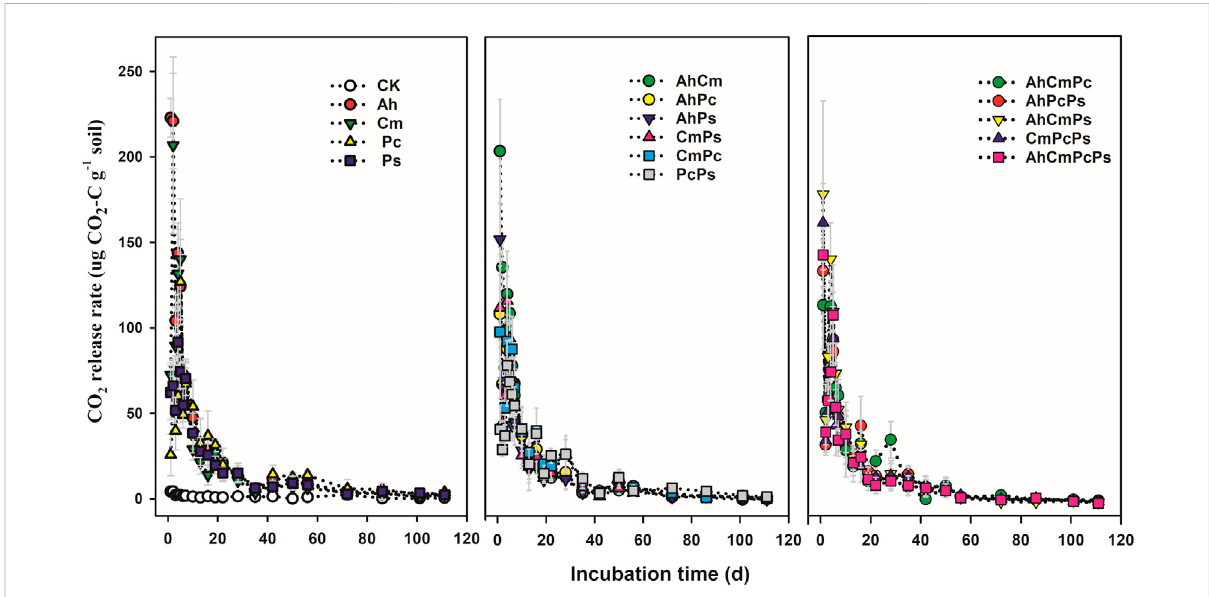
FIGURE 2 Dynamics of CO 2 emission fl uxes in control and litter addition treatments for single species, two species mixtures, and three and four species mixtures. All means are ±SE, 5 replicates per treatment.